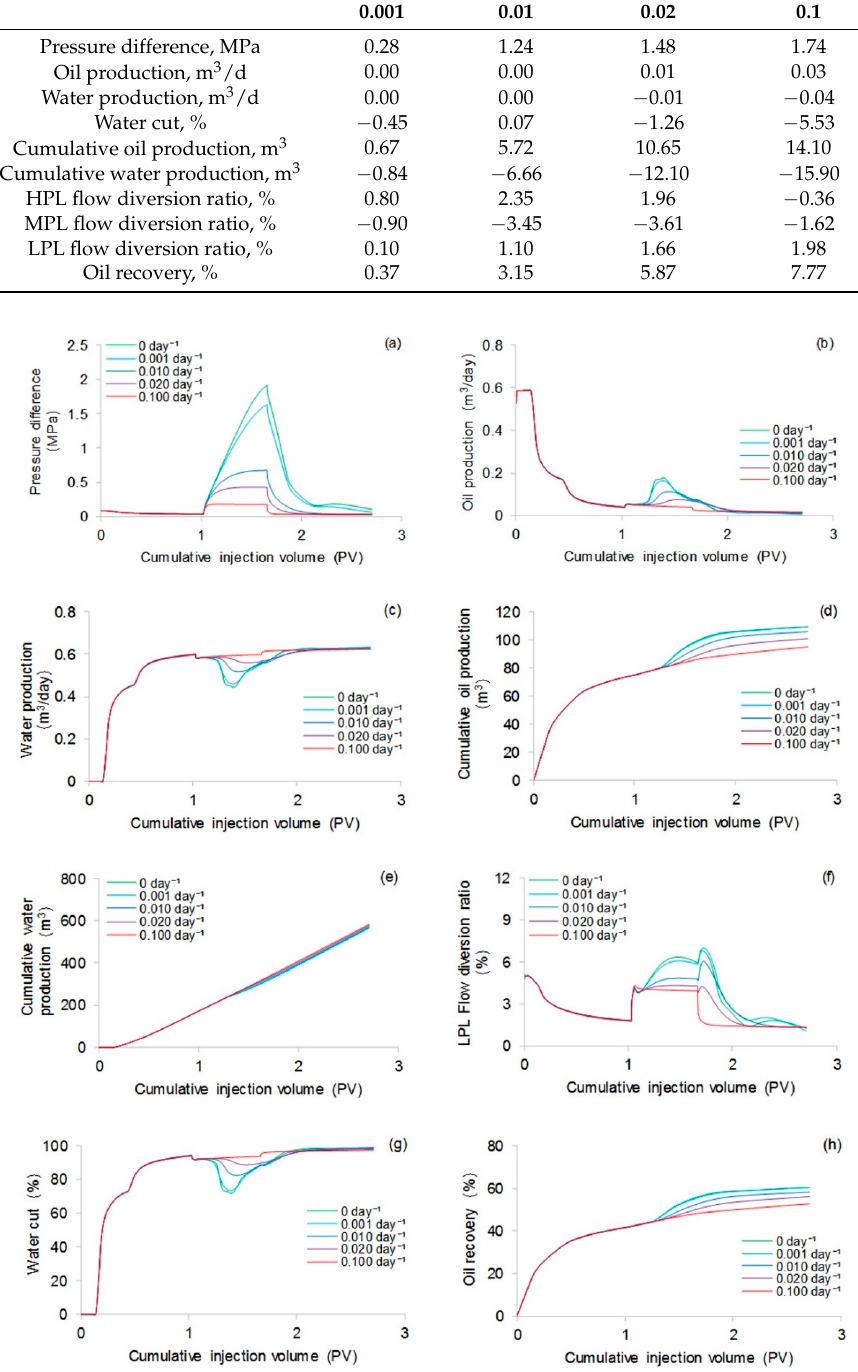
Figure 15. Comparative results for the production indicators including: ( a ) pressure difference, ( b ) oil production, ( c ) water production, ( d ) cumulative oil production, ( e ) cumulative water production, ( f ) LPL flow diversion ratio, ( g ) water cut, and ( h ) oil recovery with different first-order dynamic degradation rate constants.